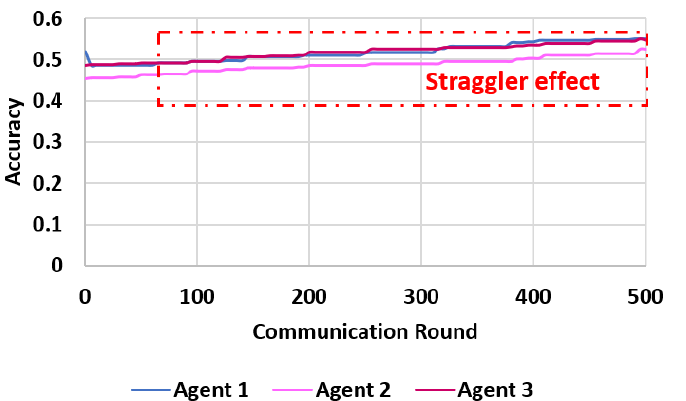
Figure 4. Straggler effects on participating FL agents’ (three agents and two stragglers) model accuracy for the prediction of critical infrastructure